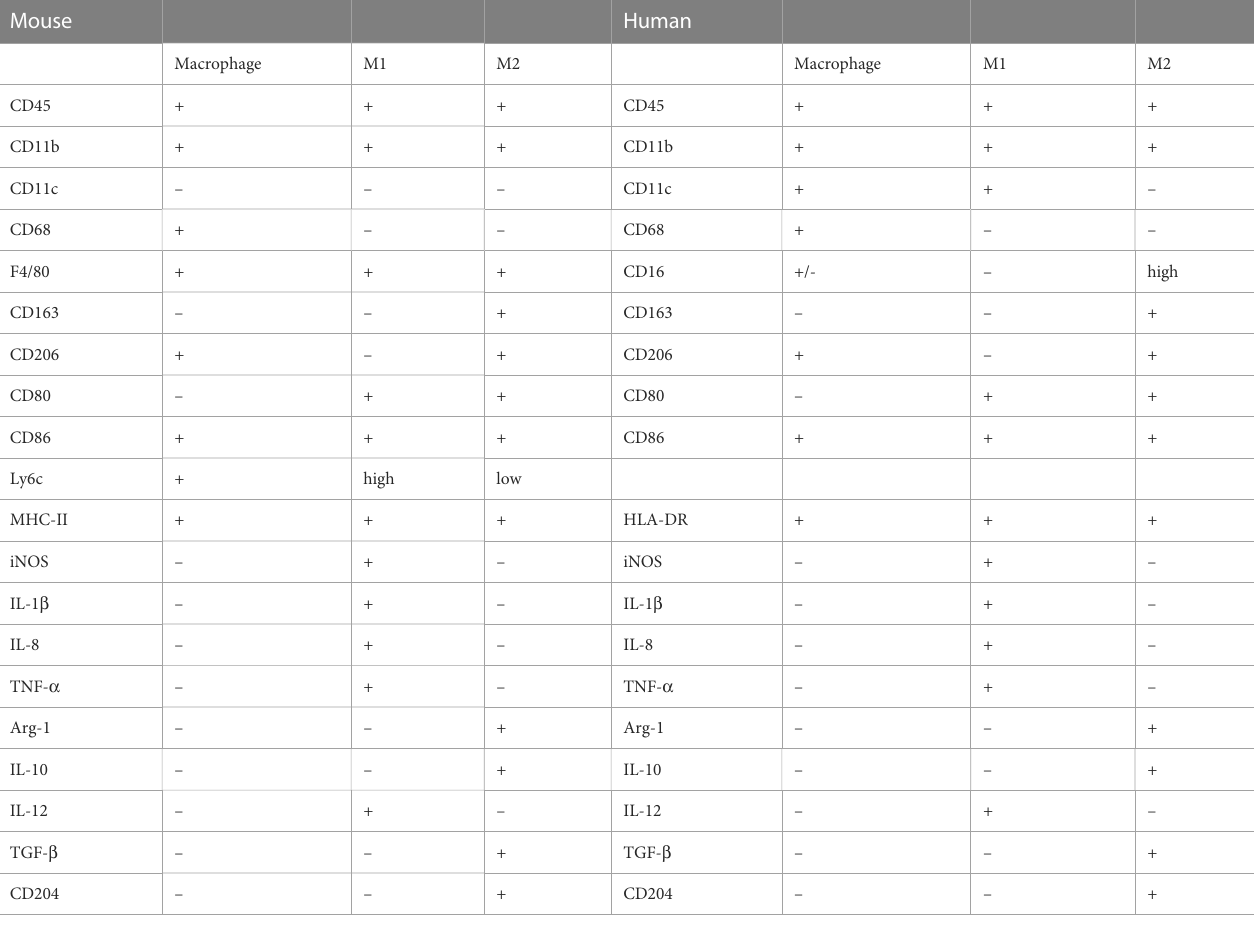
TABLE 1 Phenotypic marker molecules of murine and human macrophage subsets. Mouse